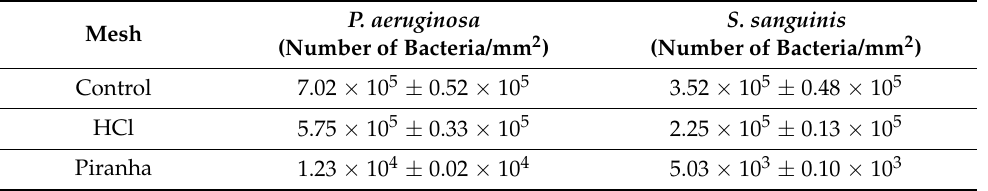
Figure 8. Ti ion release at different immersion times in Hank’s solution of different passivation treatments on cpTi. Table 6. Quantitative analysis of number of P. aeruginosa and S. sanguinis adhered on Grade 5 titanium alloy surfaces with different passivation treatments.